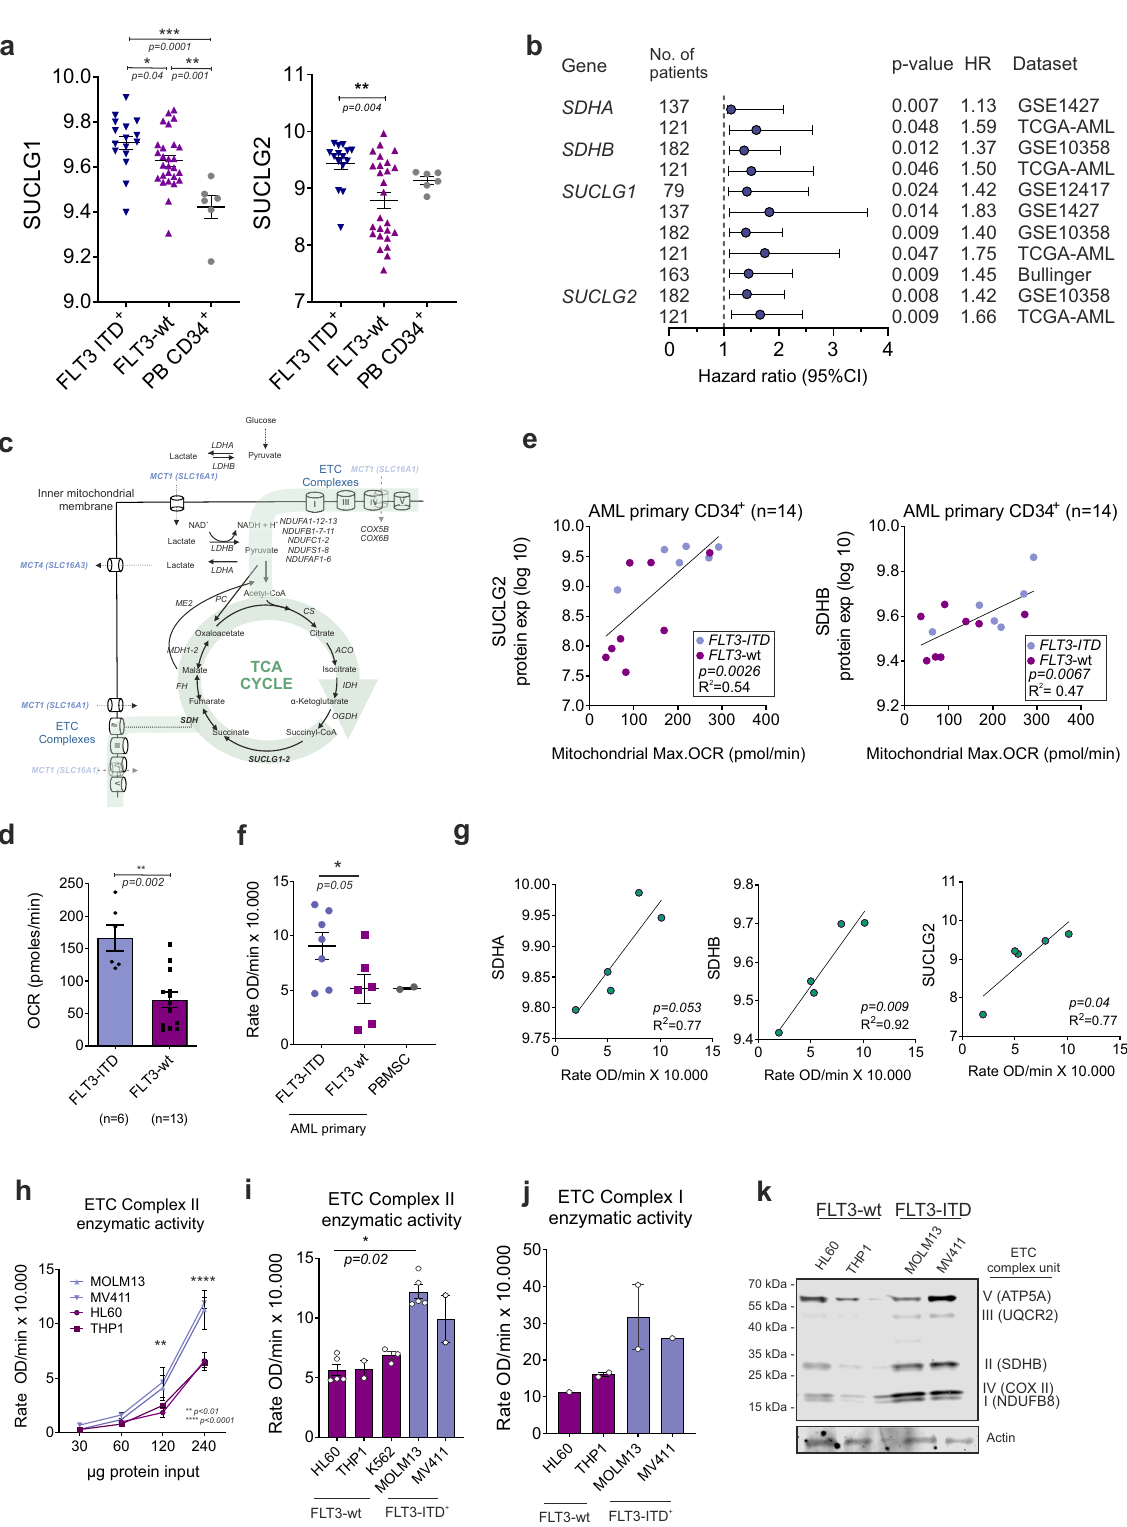
stem/progenitor cells from FLT3 -ITD + AML patients displayed (Fig. 1f), which correlated with SDHA, SDHB, and SUCLG2